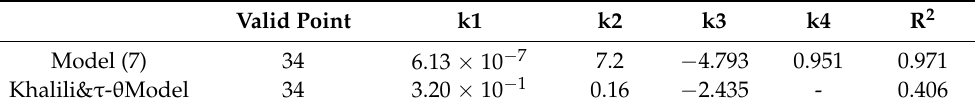
Table 4. Statistical